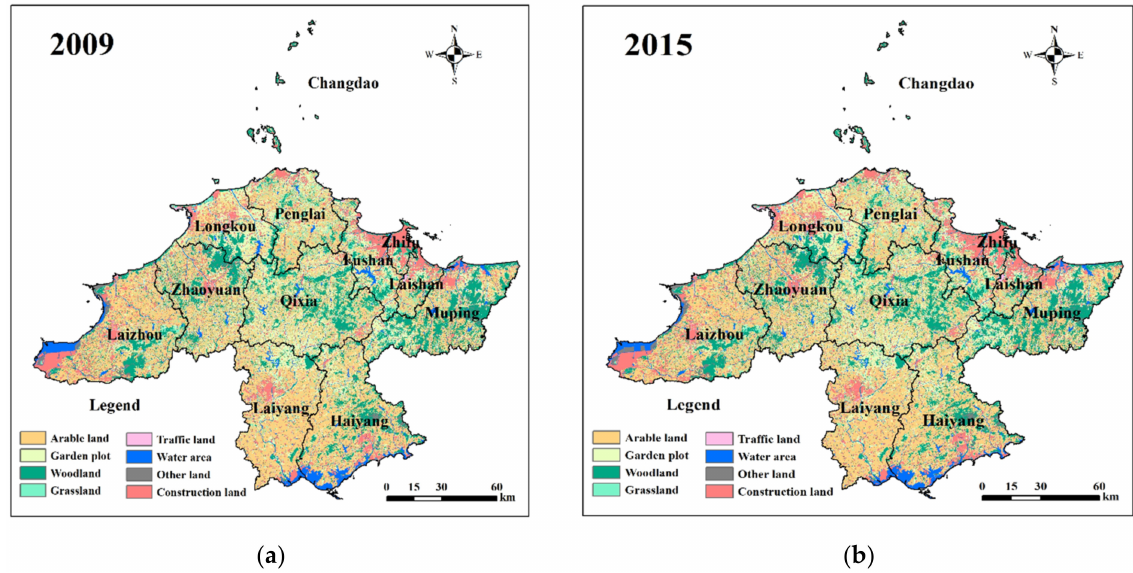
Figure 2. ( a ) Distribution of land use types in Yantai in 2009; ( b ) distribution of land use types in Yantai in